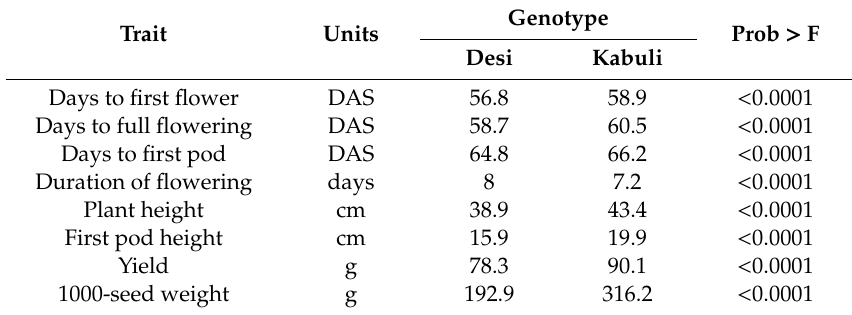
Table 6. One-way ANOVA between desi and kabuli types for flowering, architectural and production traits of the UNIVPM_Ca_core2 panel.